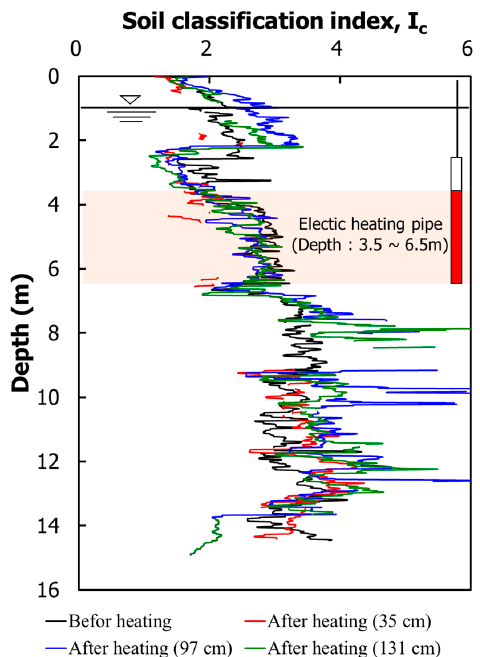
Figure 10. The Soil Classification Index obtained by the CPT tests data (before and after ground heating). Because the CPT was only possible belowground at a temperature of 50 °C, the test was performed three days after ground heating was terminated. The strength of the ground before ground